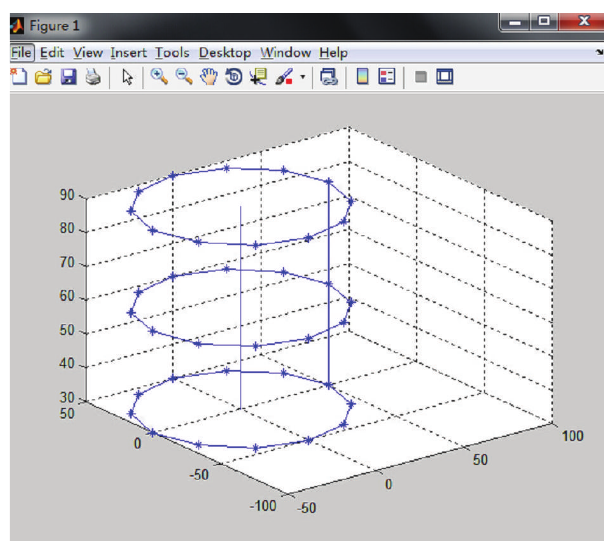
Figure 8: The ideal